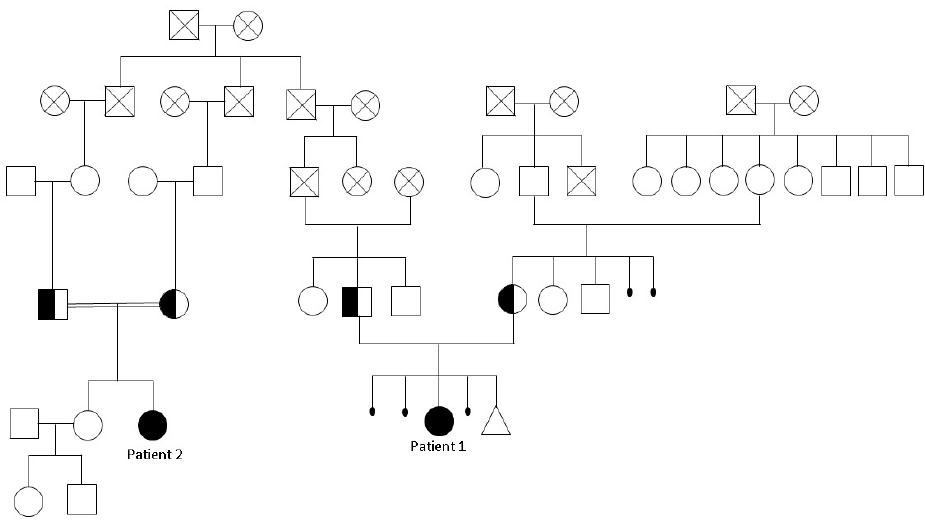
Figure 2. Family pedigree of